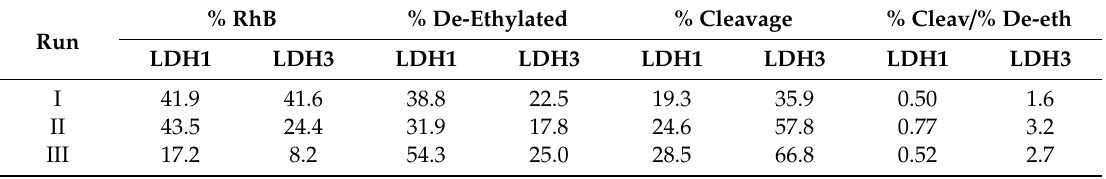
Table 3. RhB, de-ethylation, cleavage percentage and ratio between the percentage of cleaved and de-ethylated species after 5 min since start of irradiation for LDH1 (mg Ag / mL RhB = 0.30) and LDH3 (mg Ag / mL RhB = 0.15).